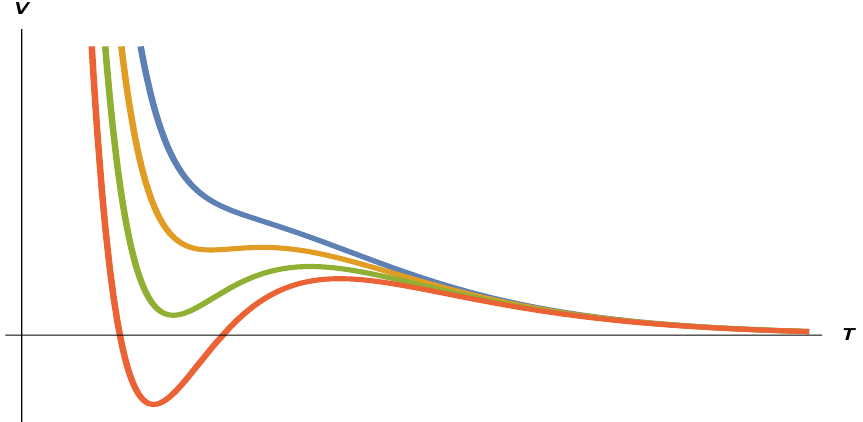
Figure 1 . A plot of V vs τ for the scalar potential V = U (ln τ ) /τ 4 , revealing a de Sitter or anti-de Sitter minimum separated from a runaway by a local maximum. The plots are obtained using the representative values k = 0 . 01 and k = − 0 . 133 (arbitrary scale). The main text describes 1 /k 3 2 /k 3 the precise parameter range required to get de Sitter rather than anti-de Sitter or a